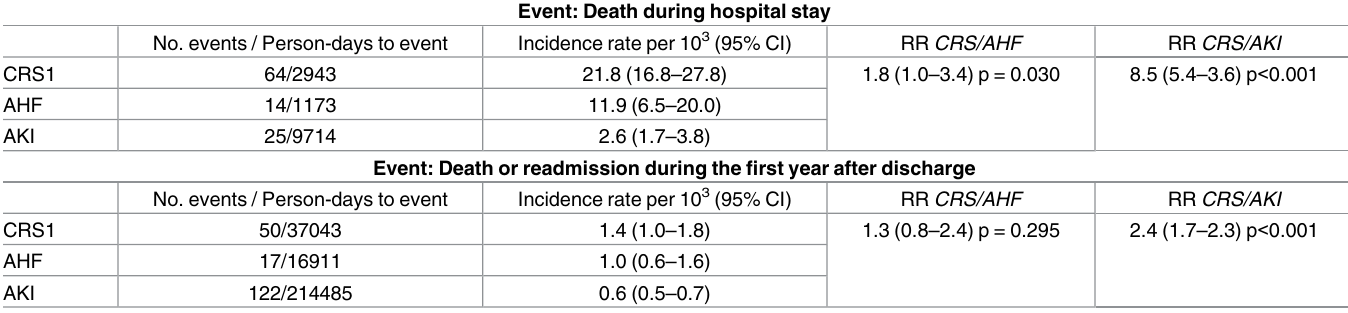
Table 2. Incidence rates of the two events studied here among patients with CRS1, AHF and AKI. Comparisonof rates (RR, 95% CI;